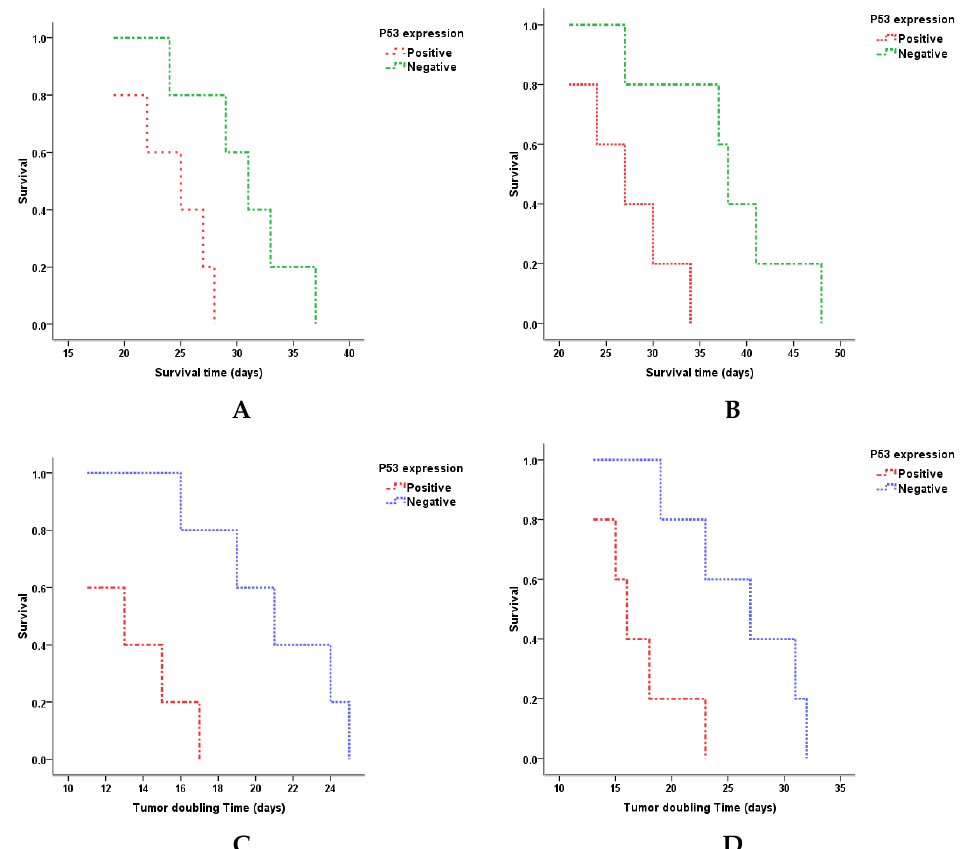
Figure 4. Kaplan–Meier actuarial analysis for animals’ survival time (plots ( A , B )) and tumor-doubling time (plots ( C , D )) in association with p53 protein expression in low-grade NMIBC PDX tumors: ( A , C ) represent the control, while ( B , D ) represent the interventional groups.